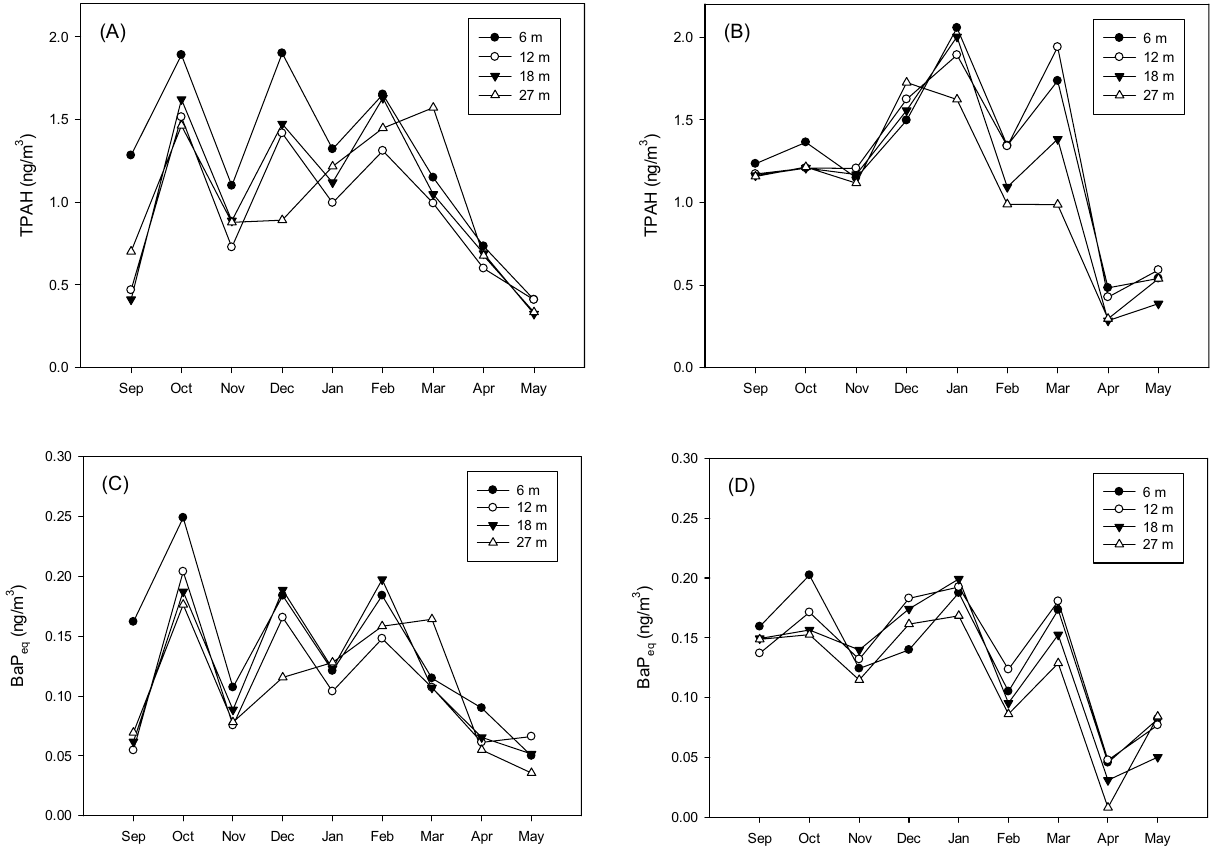
Figure 5. ( A ) Concentrations of PM 2.5 -associated PAH concentrations during daytime and ( B ) nighttime and ( C ) BaP eq concentrations during daytime and ( D ) nighttime in different